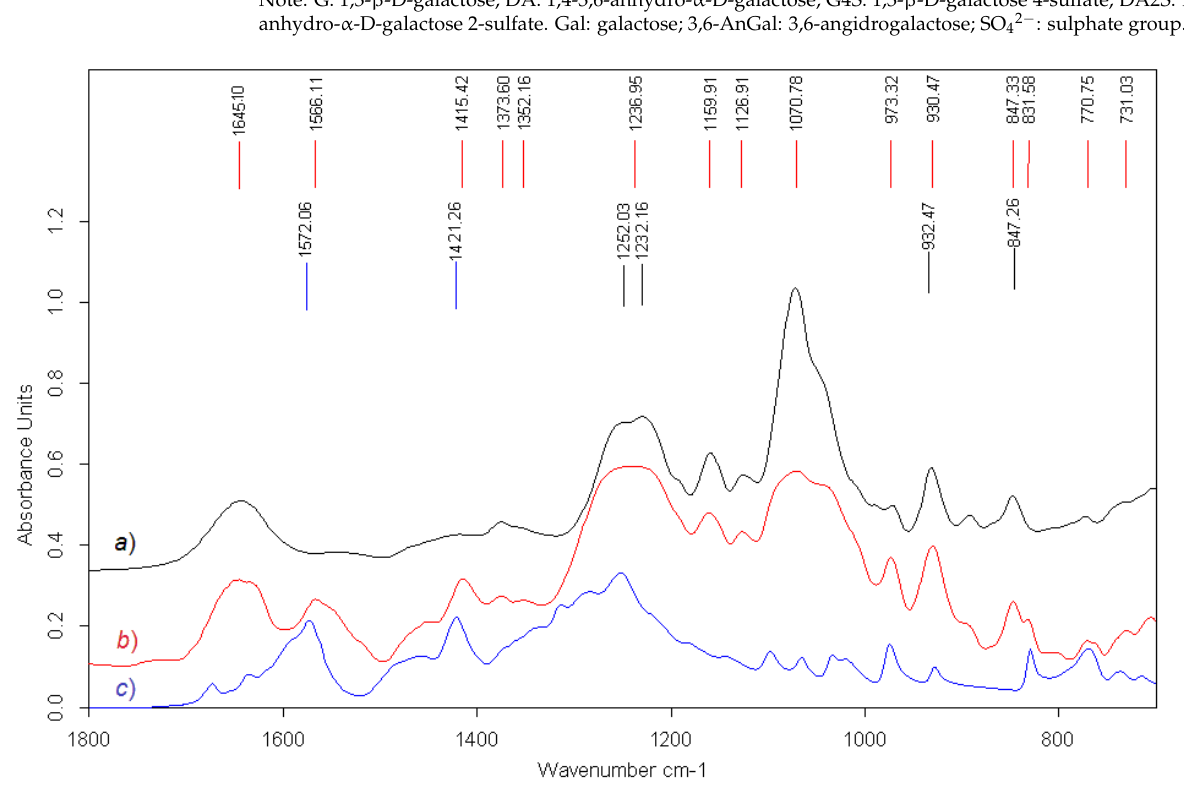
Figure 1. FTIR spectra: ( a ) κ -CRG, ( b ) κ -CRG/Ech, and ( c ) Ech.